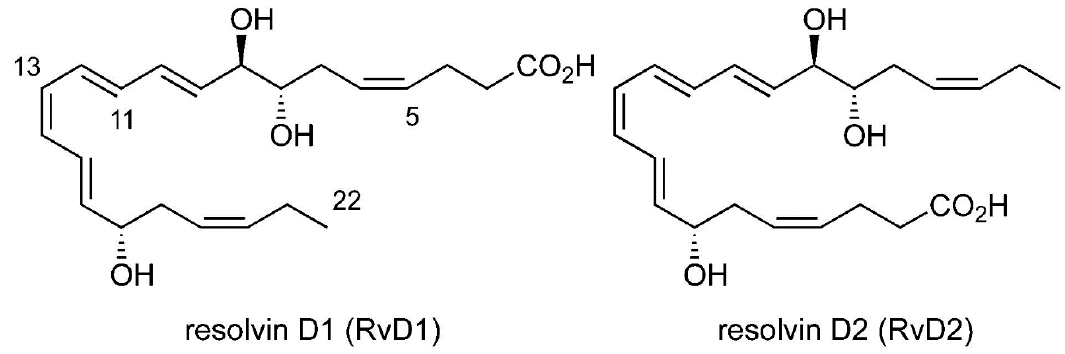
Figure 1. Structure of RvD1 and